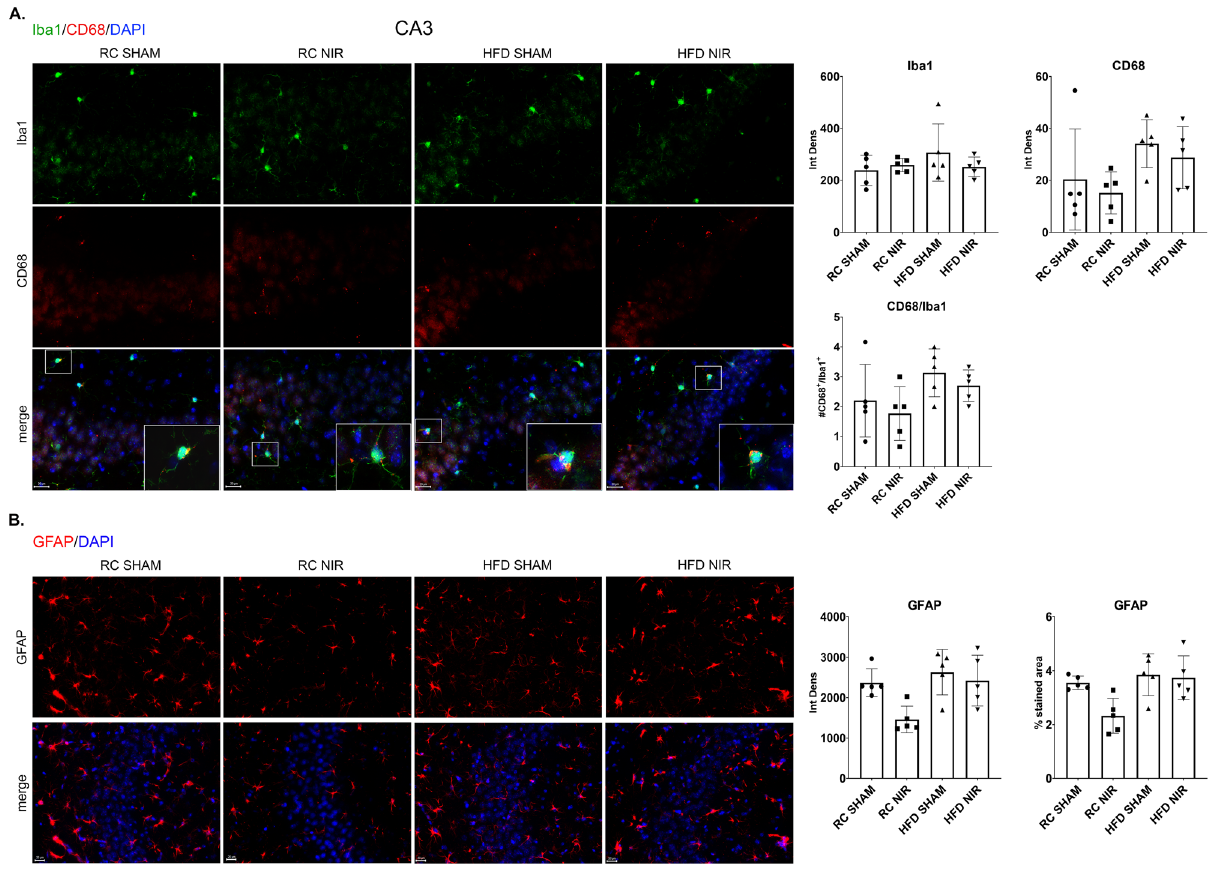
Figure 1. Glia marker expression in the CA3 of RC- and HFD-fed mice with or without NIR treatment. ( A ) Quantitative analyses of Iba-1 and CD68 showed no significant difference in microglia marker labeling in the hippocampal CA3. Magnification: 60X. ( B ) Quantitative analyses showed no change in GFAP labeling in the hippocampal CA3. Magnification: 40X. Image results of Z-stacks with pitch of 2.0 μm. n = 5 animals/group. Data are presented as mean ± SD. Each point is the average of 6 images/animal from 2 technical replicates. Statistical analyses: one-way ANOVA with Tukey’s post-hoc test. Single images were generated with Keyence BZ-X800 Analyzer (www. keyen ce. com). Graphs were created with GraphPad Prism 8.4.3 and 9.3.1 software (https:// www. graph pad. com/). Images and graphs were composed in Adobe Photoshop 22.2.0 (https:// www. adobe. com/ produ cts/ photo shopf amily.